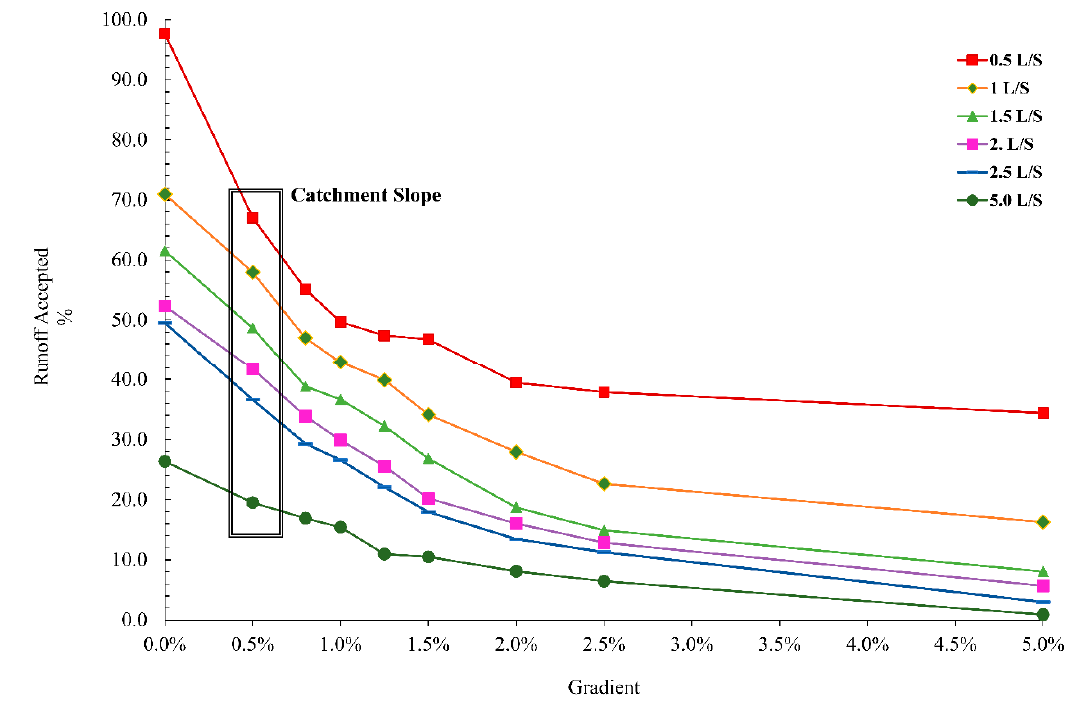
Figure 4. Analyzing the capture efficiency of TREENET inlet plate with approach flowrate. Accep- tance rate for each flowrate corresponding to different gradients are presented in separate colors. The catchment gradient is highlighted in the figure.